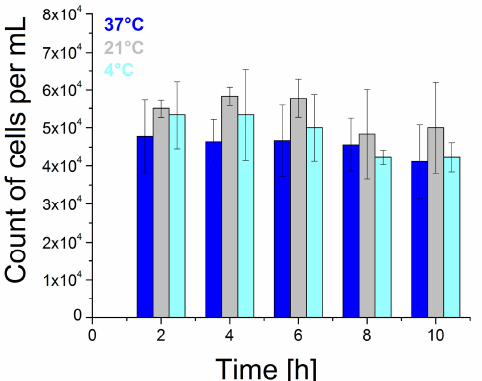
Figure 2. Viability of the SK-BR-3 cells in PBS in the incubator (37 ◦ C), at laboratory temperature (20 ◦ C) and in refrigerator (4 ◦ C). The data represent mean ± SD obtained from 3 independent experiments in each series.